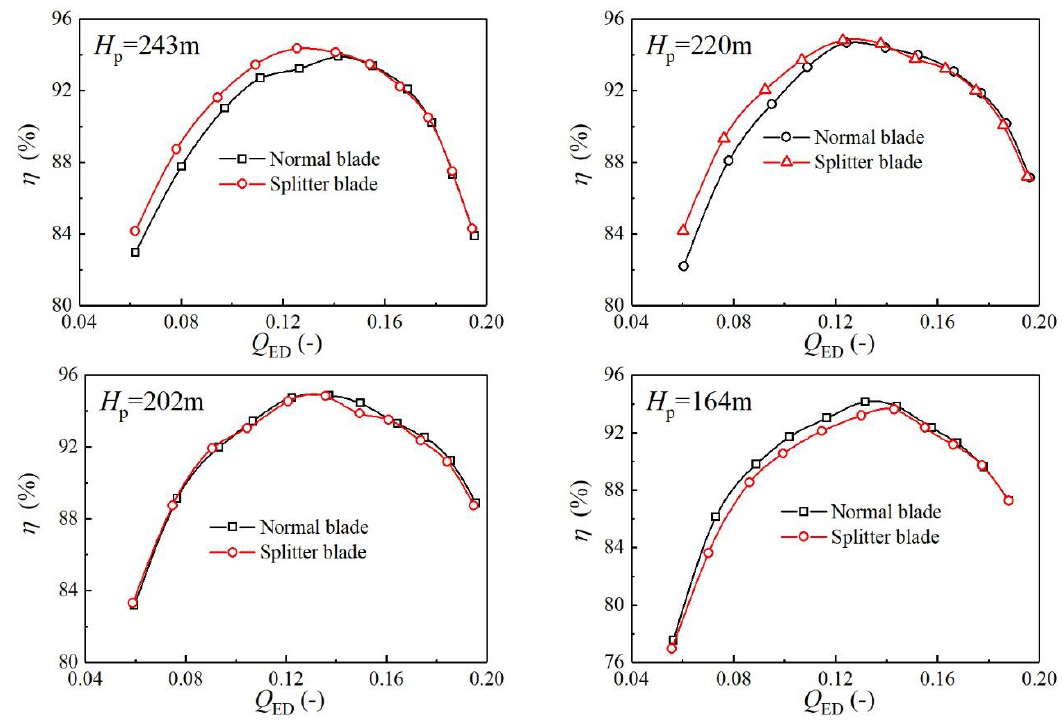
ffi ciencies under di ff erent Figure 7. Comparison of efficiencies under different heads. Figure 7. Comparison of e